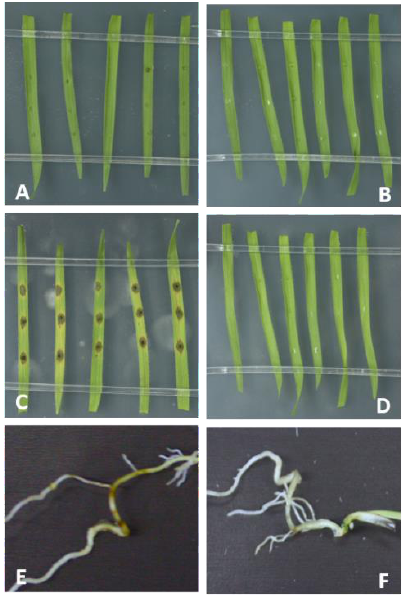
Figure 3. Brachypodium blast caused by M. oryzae Mo 70-15 on leaves and roots of B. distachyon Bd21-3. ( A , D ) Detached 21-day-old Bd leaves were drop-inoculated with 10 μL of Mo suspension (50,000 conidia/mL) and kept for ( A ) 2 and ( C ) 4 days at high humidity, or mock-inoculated ( B , D ) with Tween water. Roots of 7-day-old Bd seedlings were ( E ) drop-inoculated with 1 mL of Mo suspension (250,000 conidia/mL) or ( F ) mock-inoculated or and kept for 4 days under high humidity at 16 h light/8 h dark cycle at 22 °C/18 °C.